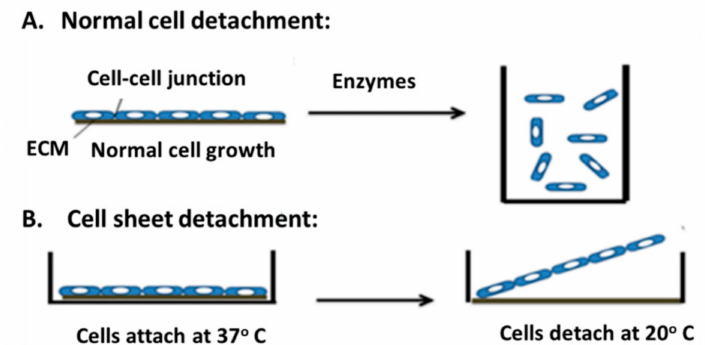
Figure 1. An illustration of standard cell detachment vs cell sheet detachment. ( A ) Cells harvested through enzymatic digestion. In this approach, cells lose their cell–cell junctions which cause them to float in a regular culture dish. ( B ) Cell sheet detachment through temperature control without any enzymatic digestion using temperature responsive culture dish. The temperature is lowered from 37 to 20 ◦ C, which maintains the cell–cell junctions and ECM